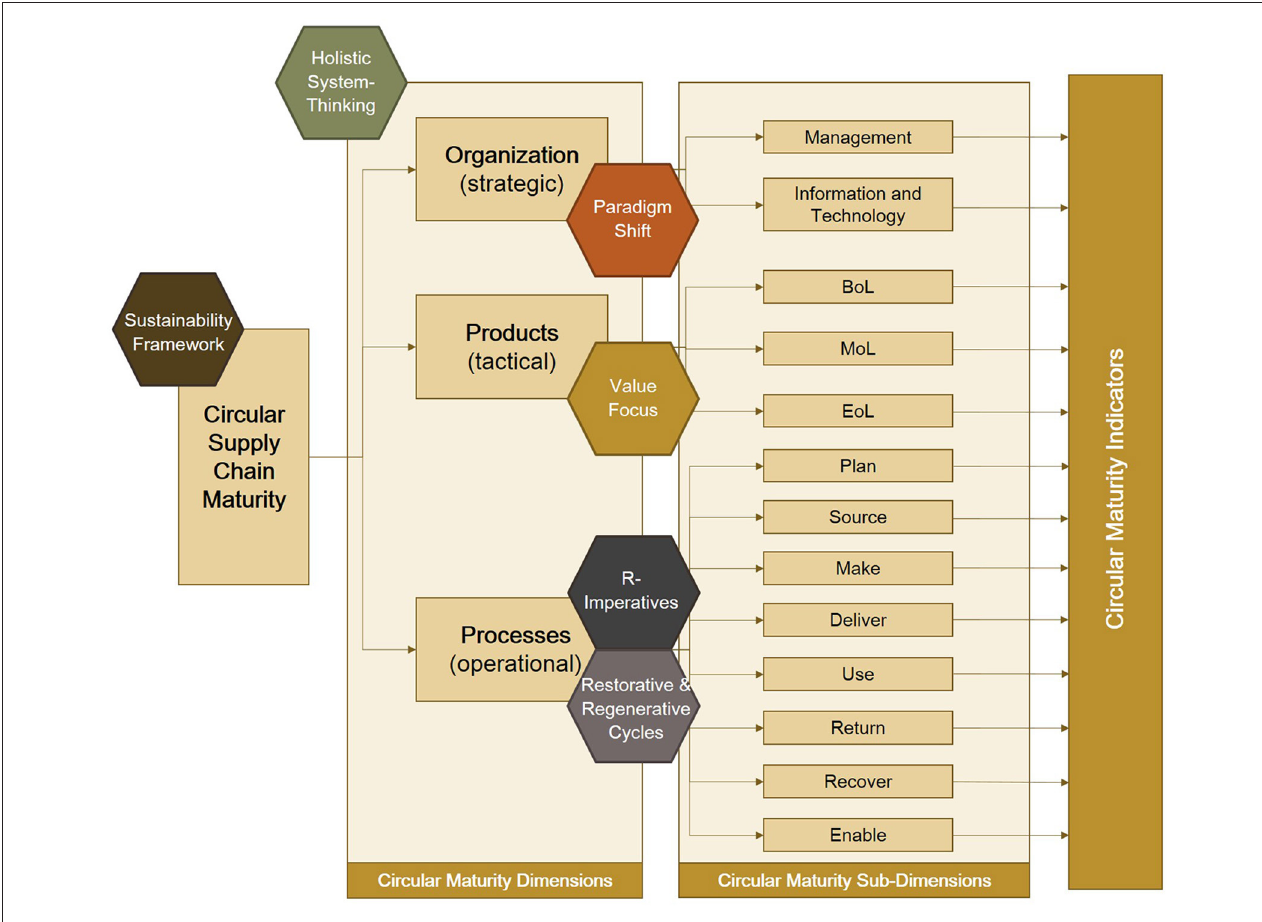
FIGURE 7 | Circular supply chain